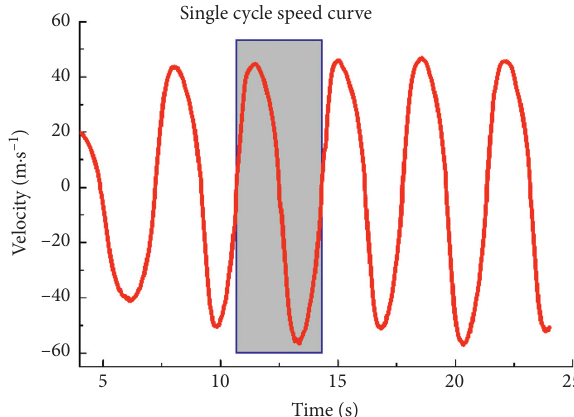
Figure 5: Time history of the air velocity at the outlet of the